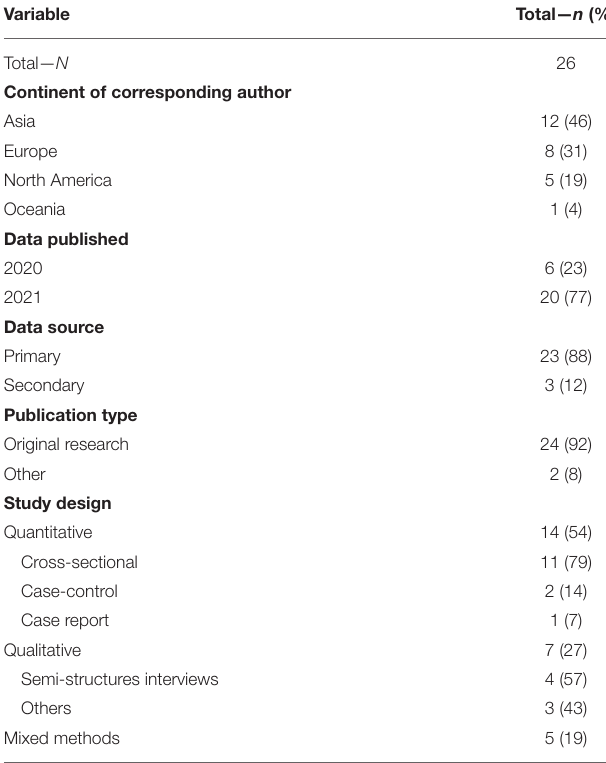
TABLE 2 | Description of the 26 studies